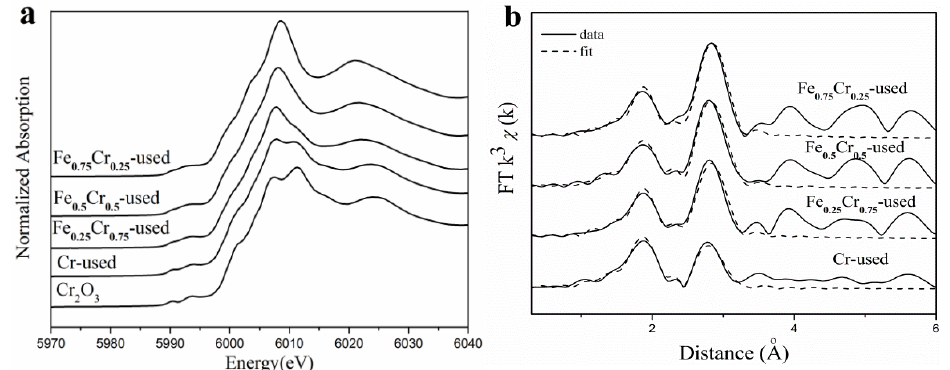
Figure 7. Cr K-edge XANES profiles ( a ) and EXAFS fitting results in R space(b) of used FeCrO x catalysts.